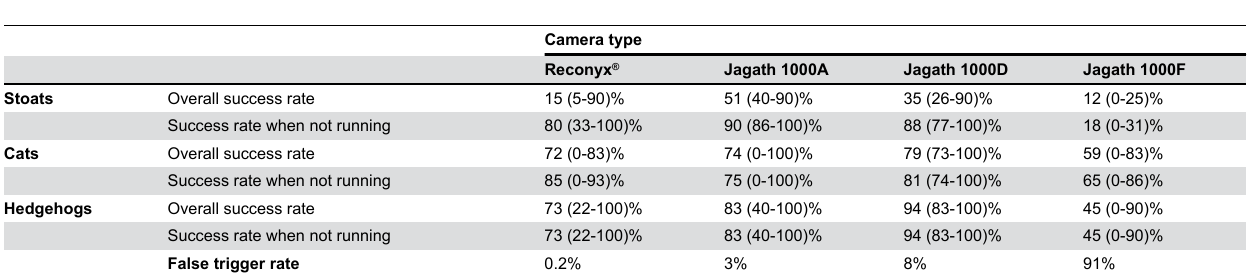
Table 2. Success rates in detecting captive stoats ( Mustela erminea ), feral cats ( Felis catus ) and hedgehogs ( Erinaceus europaeus ) encountering four alternative designs of camera trap, and the rate of false triggers for each type of camera.